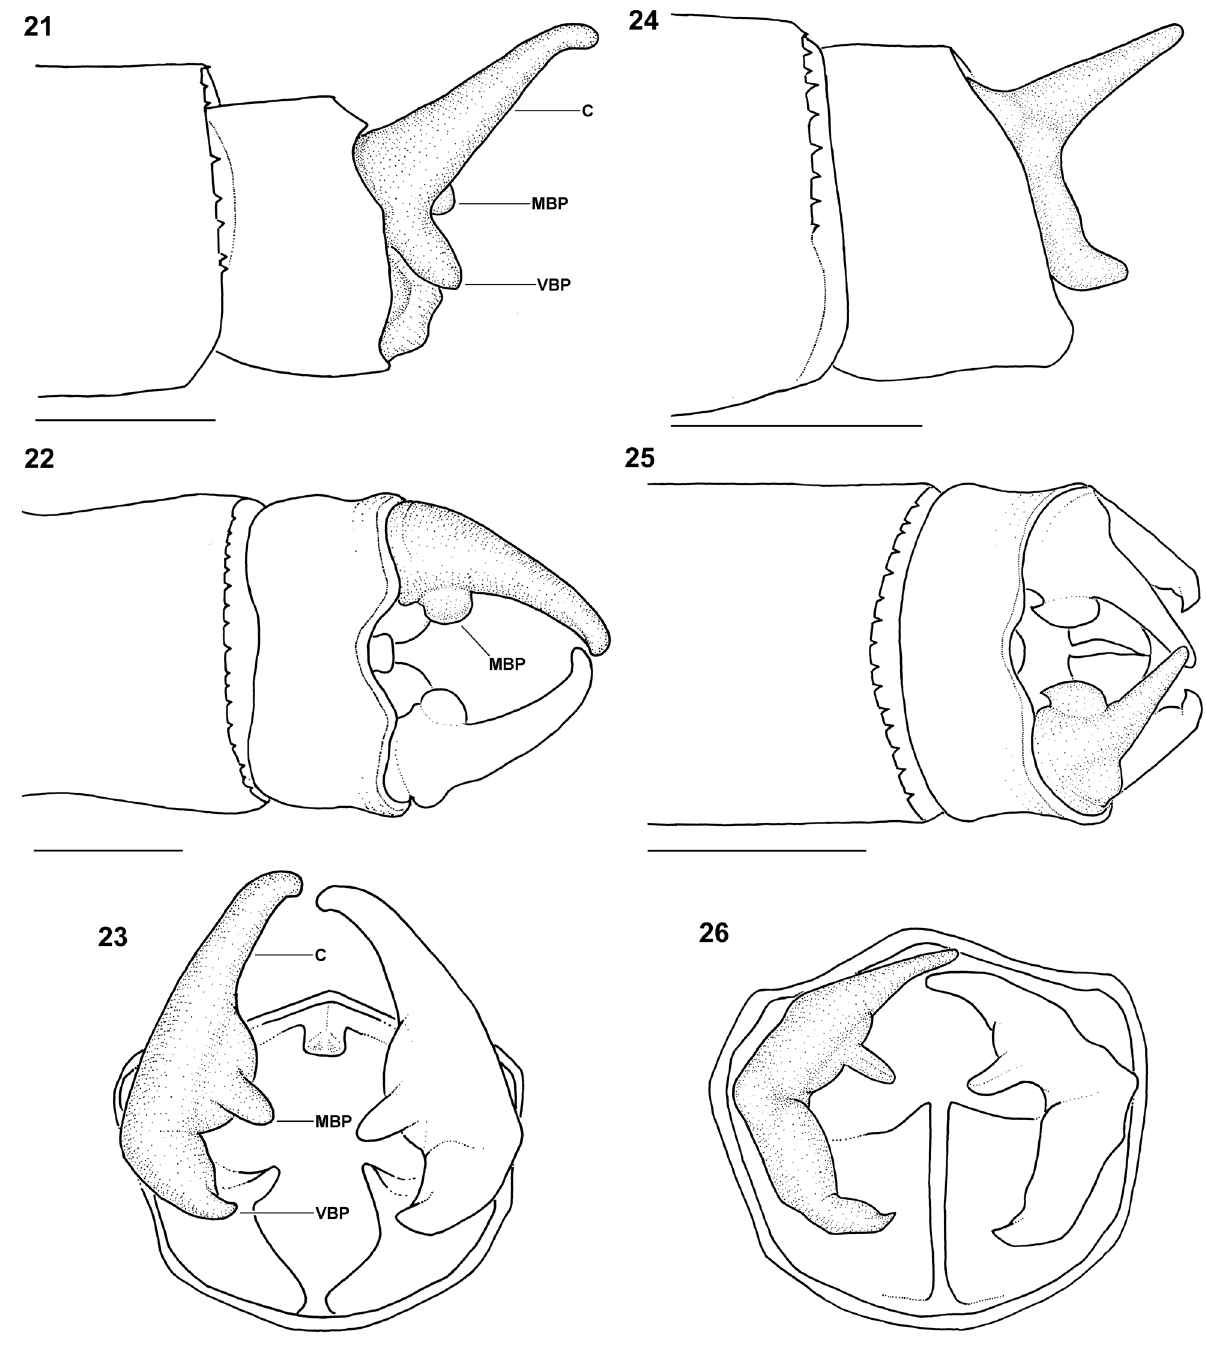
Figures 21–26. Caudal appendages of males of Forcepsioneura : (21–23) F. serrabonita sp. nov., holotype (Brazil. BA: Camacan, DZRJ 0050); (24–26) F. regua sp. nov., holotype (Brazil. RJ: Cachoeiras de Macacu, DZRJ 2071); (21, 24) lateral view; (22, 25) dorsal view; (23, 26) posterior view. Scale bars = 1